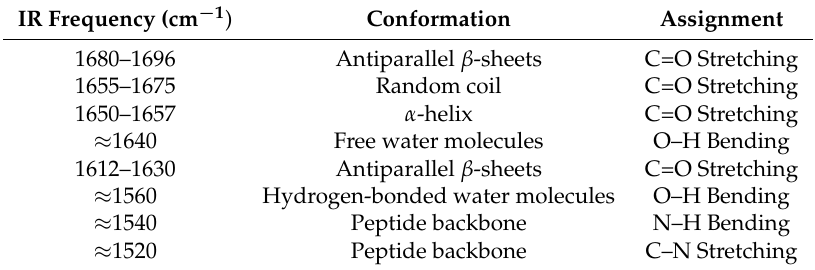
Table 1. Assignment of the principal IR bands in the spectral region of Amide I and II between 1500 and 1700 cm − 1